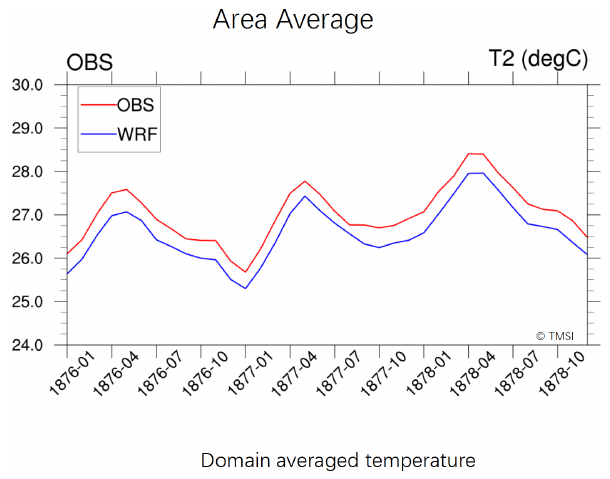
Figure 6. Correlation of Weather Research and Forecasting (WRF) and OBS simulations of DJF 1877–1878 from seven